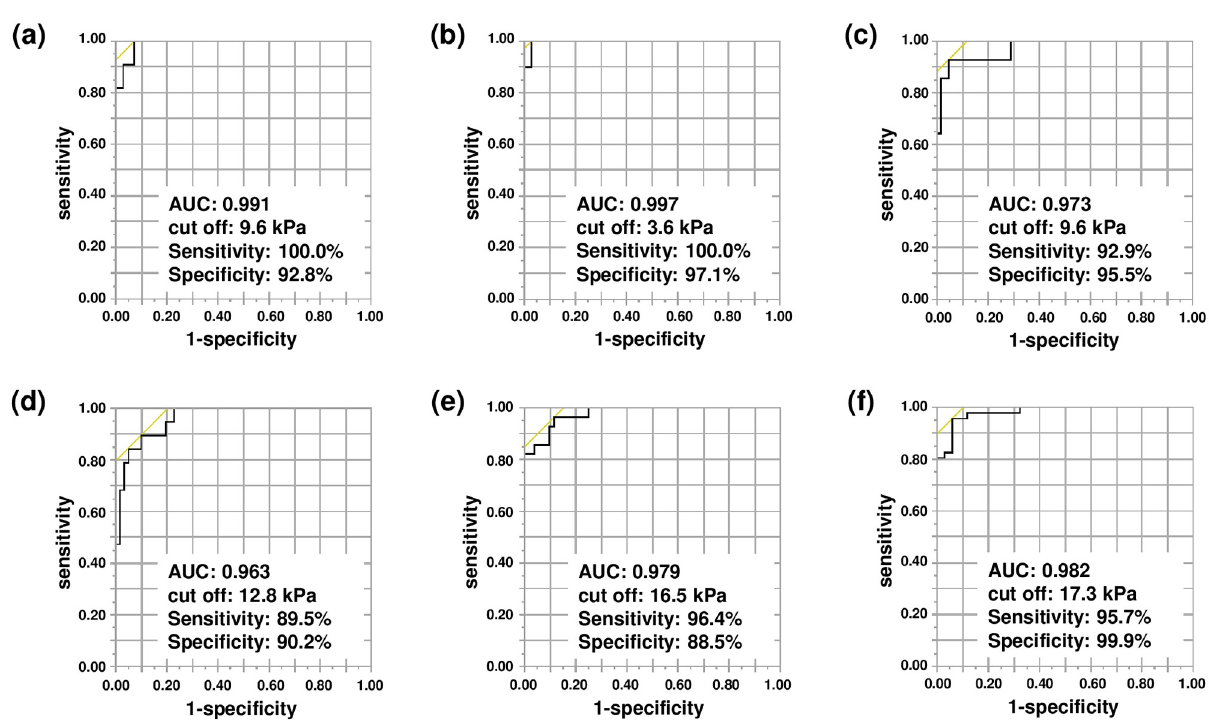
Fig 3. Receiver operating characteristic curve of tongue pressure for predicting dysphagia diet form. FILS � 7 (A), Code � 1 (2013 Japanese Dysphagia Diet Criteria) (B), Code � 2 (C), Code � 3 (D), Code � 4 (E), and Code 5 (F).